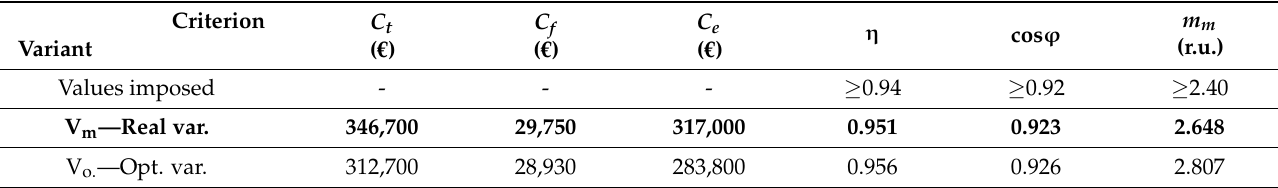
Table 1. The values obtained for the analyzed